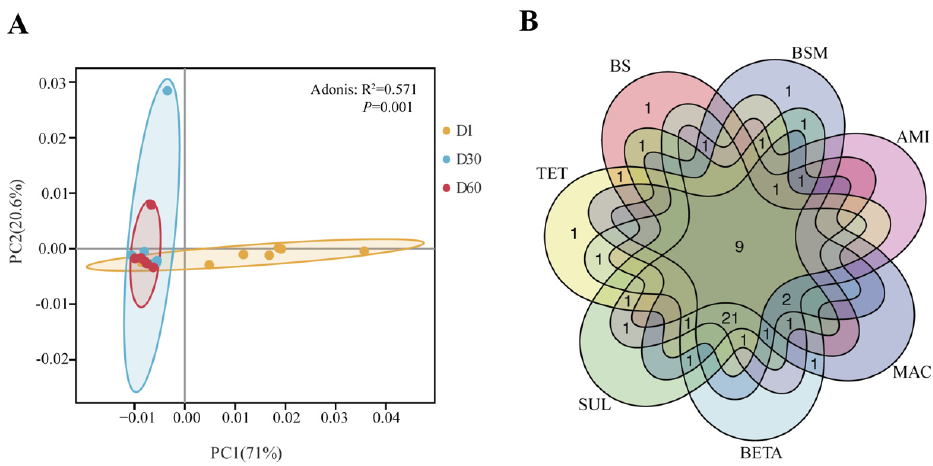
Figure 2. Comparison of ARG profiles among different samples. ( A ) PCA plots of different soil samples. ( B ) Shared ARGs across seven groups.